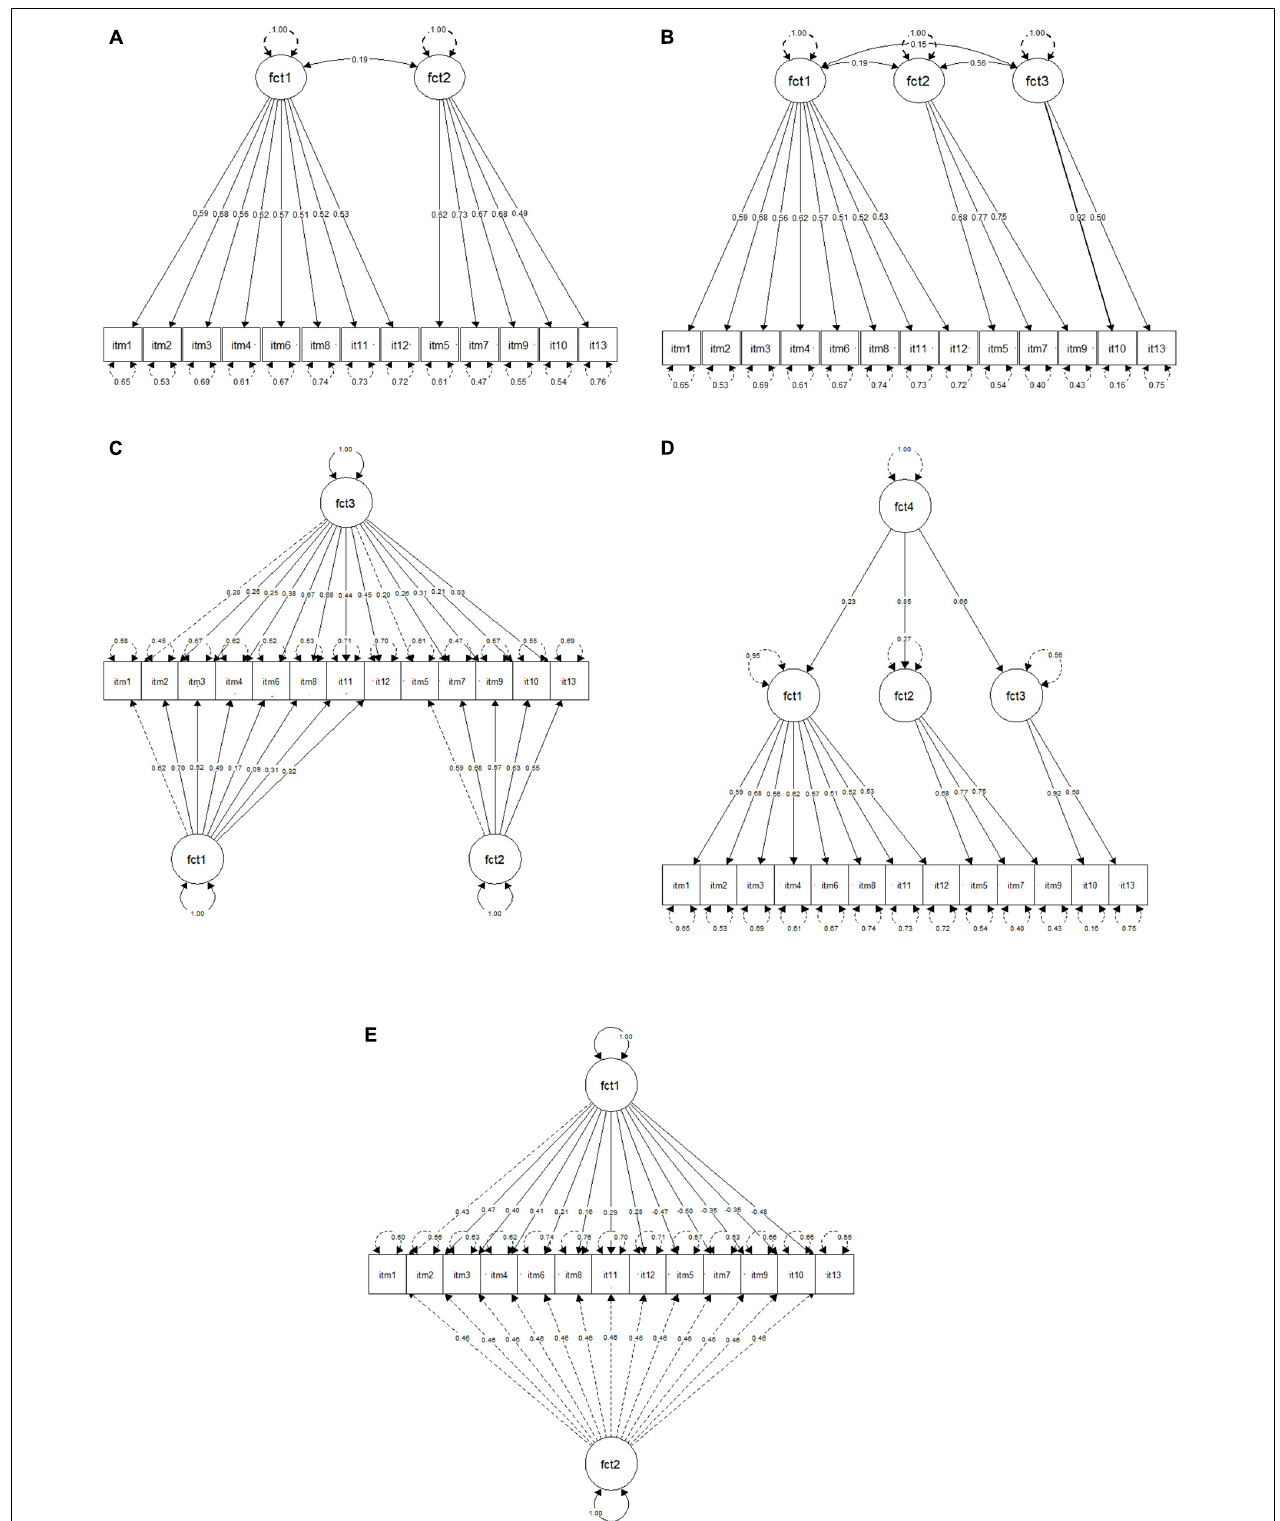
FIGURE 4 | Standardized factor loadings for the two-, three-, bifactor, hierarchical, and random item intercept models of the MCSDS – form C ( n = 2,407). (A) Two-factor model. (B) Three-factor model. (C) Bifactor model *. (D) Hierarchical three-factor model. (E) Random item intercept factor model. * Loading between factor 2 and item 5 is fixed to 1 for model identification. Covariances between specific factors and between general and specific factors are fixed to 0.